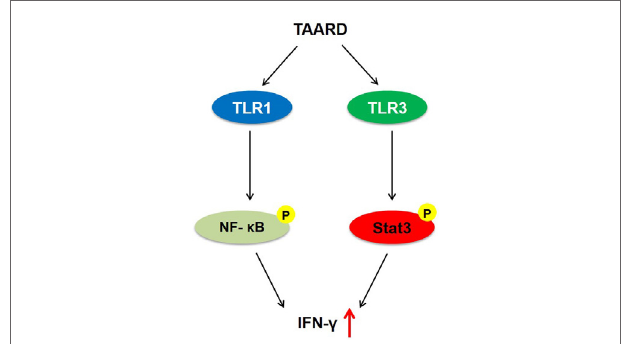
FigUre 6 | A proposed model by which TAARD stimulates interferon- γ secretion in human natural killer cells via TLR1-NF- κ B and TLR3–STAT3 signaling